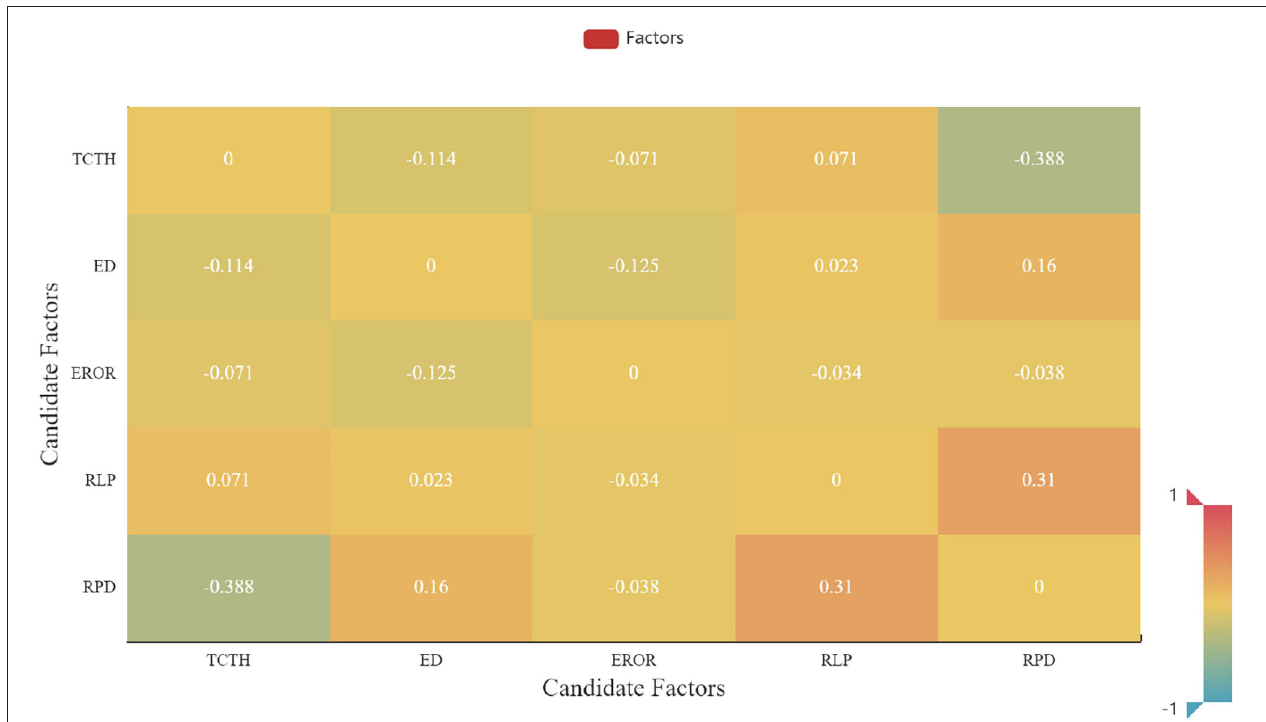
FIGURE 9 | The distribution of Pearson product-moment correlation coefficient.